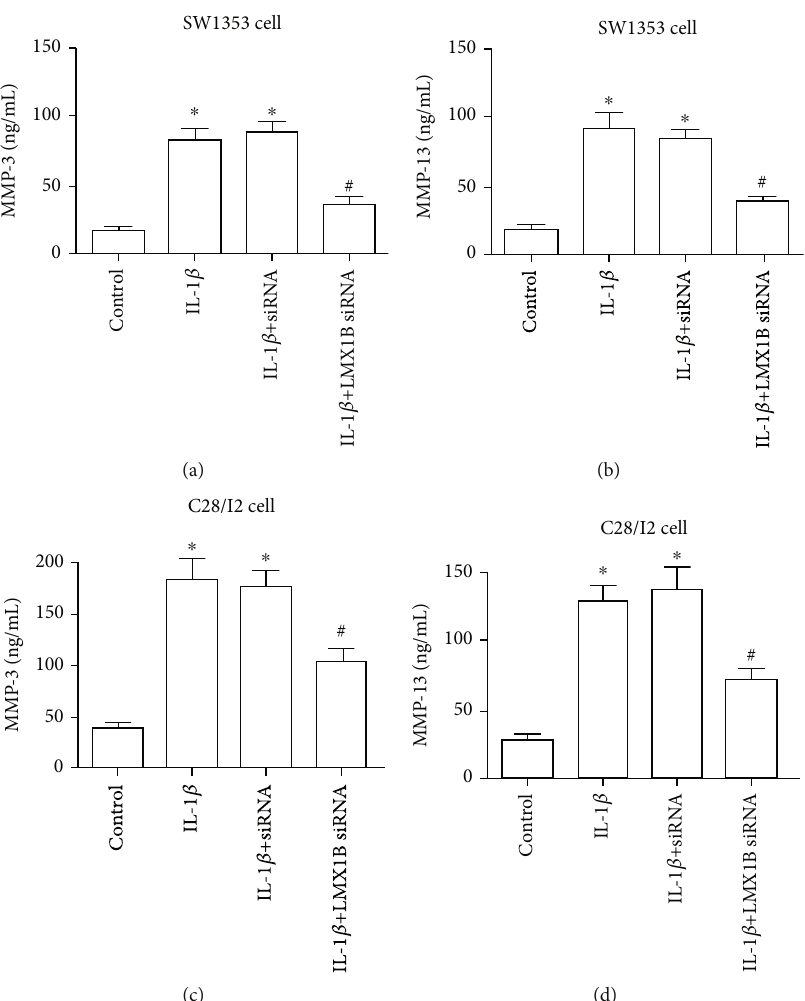
Figure 6: LMX1B depletion suppressed IL-1 β -induced MMP3 and MMP13 expression. ELISA kits were used to determine the expression of MMP3 (a and c) and MMP13 (b and d). SW1353 and C28/I2 cells were transfected with control siRNA or LMX1B siRNA for 24h by using Lipofectamine 2000 reagent and then treated with 10ng/ml IL-1 β for 24h. ∗ P < 0 : 05 , compared with the control group; # P < 0 : 05 , compared with the IL-1 β group. All experiments were repeated three